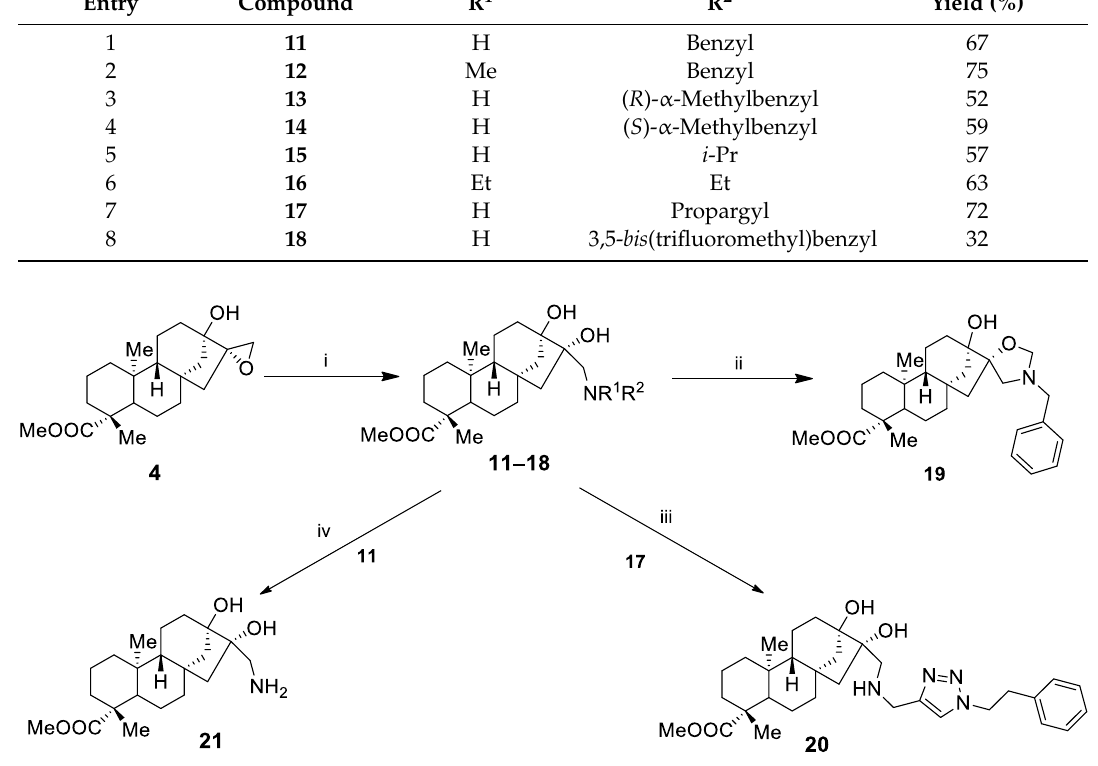
Table 1. Ring opening of 4 with primary and secondary amines according to Scheme